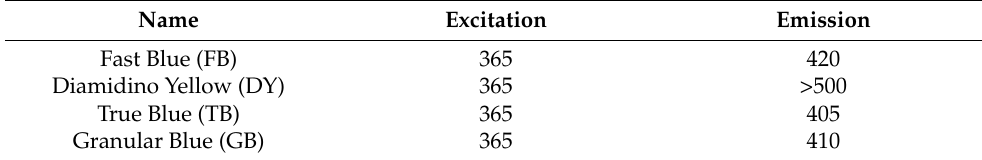
Table 1. Retrograde dyes with their excitation and emission